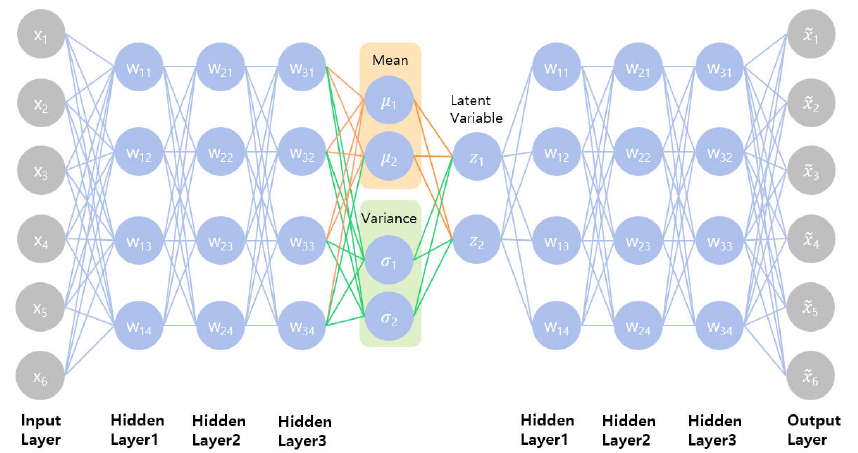
Figure 7. Architecture of face-based variational